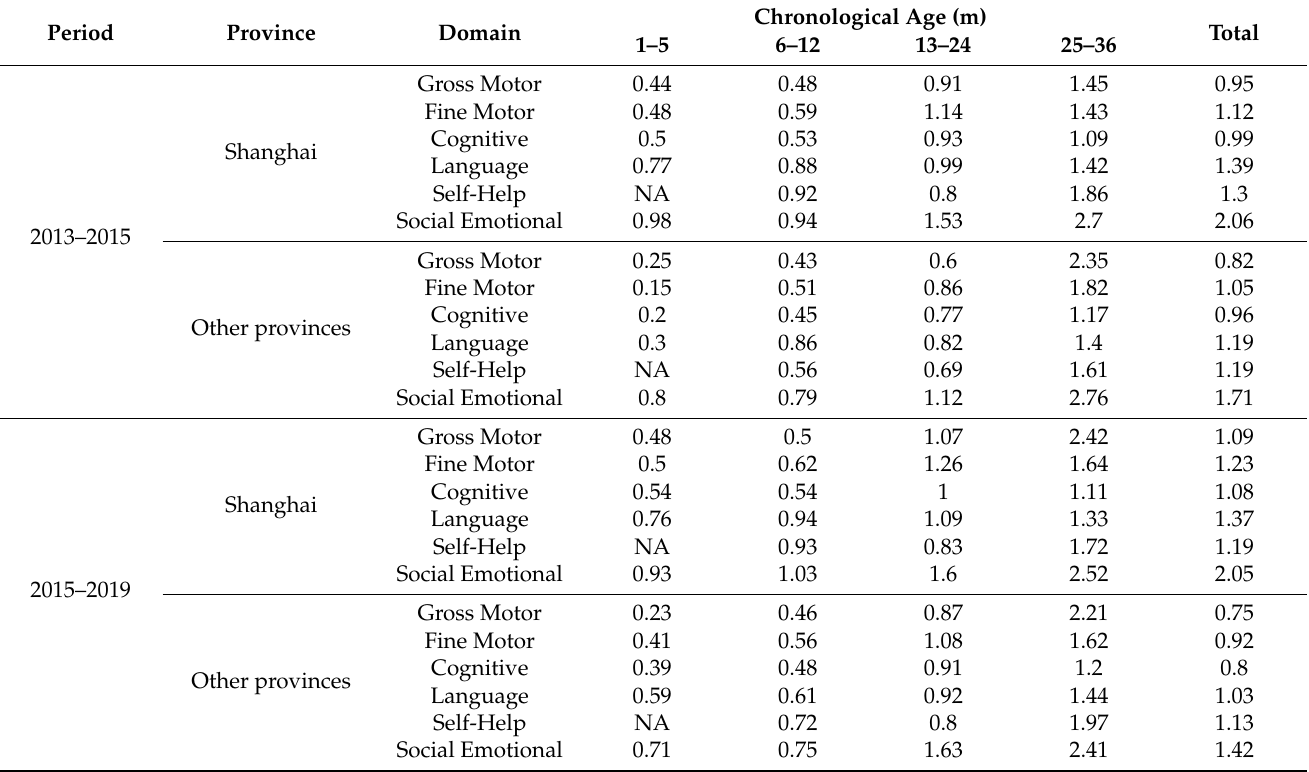
Table 5. Standard errors of measurement of the C-LAP’s six domains by period and province.